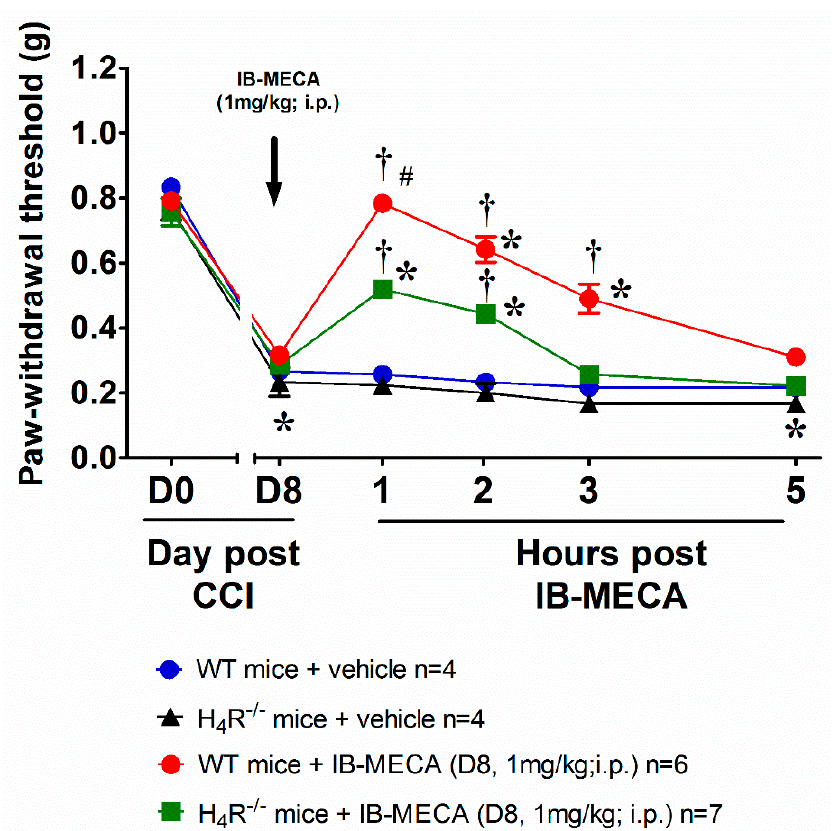
Figure 2. Anti-allodynic effect of A 3 AR agonist IB-MECA on CCI-induced neuropathic pain in WT and H 4 R − / − mice. Sciatic nerve ligation was performed in WT and H 4 R − / − mice 8 days before the acute injection of IB-MECA (1 mg/kg, i.p.). The response to a non-noxious mechanical stimulus was assessed by the Von Frey test. Measurements were performed before and 1 h, 2 h, 3 h and 5 h after IB-MECA administration. Values reported in the graph are referred to the tests conducted on the ipsilateral paw. Data are mean ± SD for n mice per group; * p < 0.05 vs. Day 0 by two-way ANOVA with Dunnett’s test; † p < 0.001 vs. Day 8 by two-way ANOVA with Turkey comparisons; # p < 0.001 vs. H 4 R − / − mice + IB-MECA (1 mg/kg) by two-way ANOVA with Tukey’s comparisons.